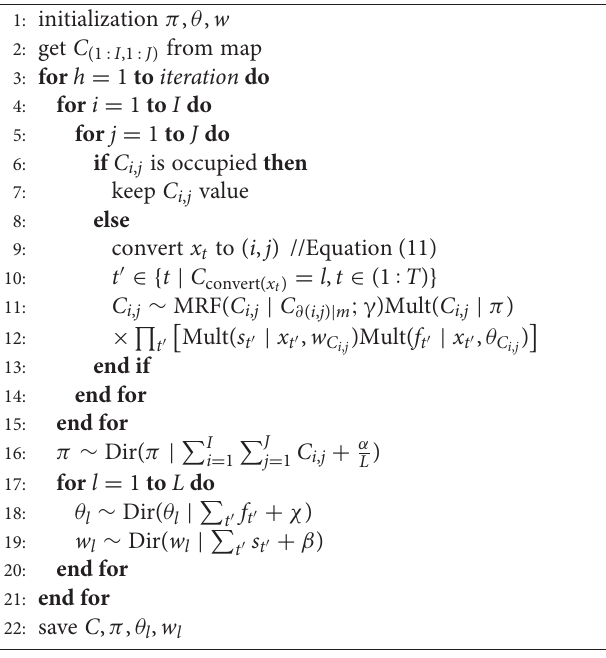
Algorithm 1 Semantic mapping based on spatial